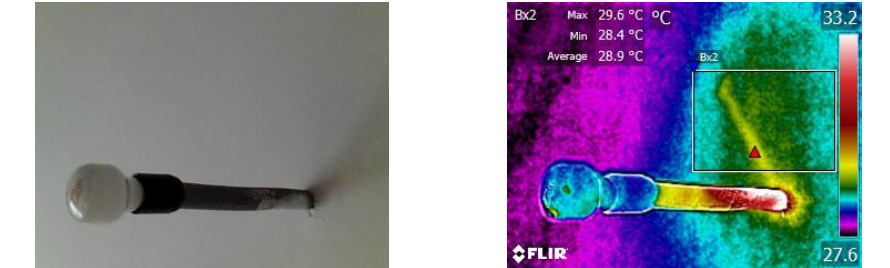
Figure 12. Finding a power supply cable with active thermography.